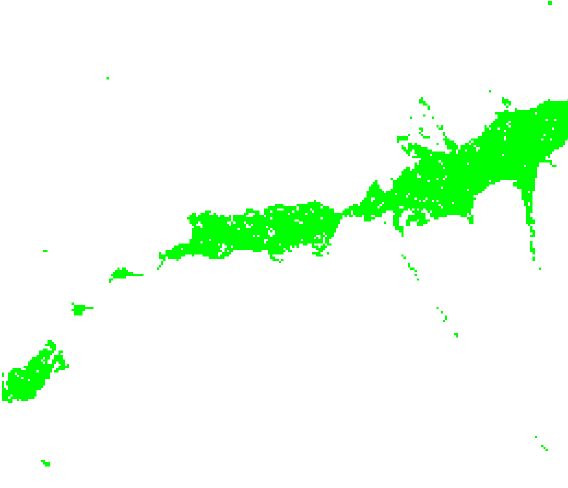
Figure 4. A subsystem of low terrain complexity was extracted from Figure 2. This is a flat zone around the river Soummam, with complexity below the threshold line on the left in Figure